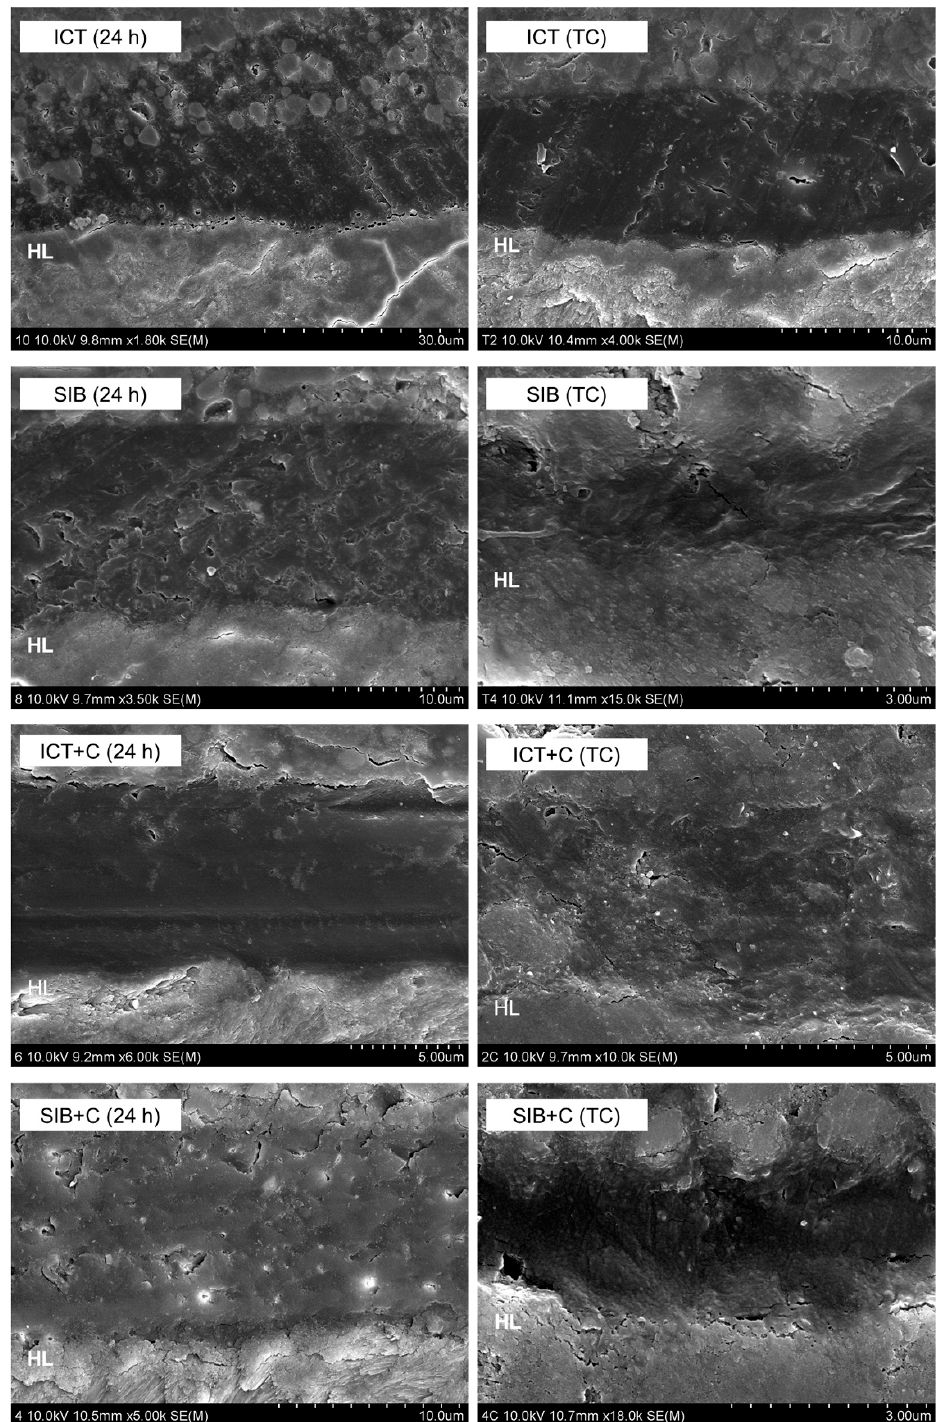
Figure 4. (continued on next page). Representative SEM images of the resin-dentin interfaces at 24 h and after thermocycling (TC). The structure marked with HL represents the hybrid layers. In contrast to the other group, the control group (CON) exhibited noticeable silver infiltration (arrows) throughout the hybrid layer after TC. ICT: icaritin; FIS: fisetin; SIB; silibinin; CPIC: calcium phosphate ion clusters; ICT + C: icaritin and CPIC combination; FIS + C: fisetin and CPIC combination; SIB + C: silibinin and CPIC